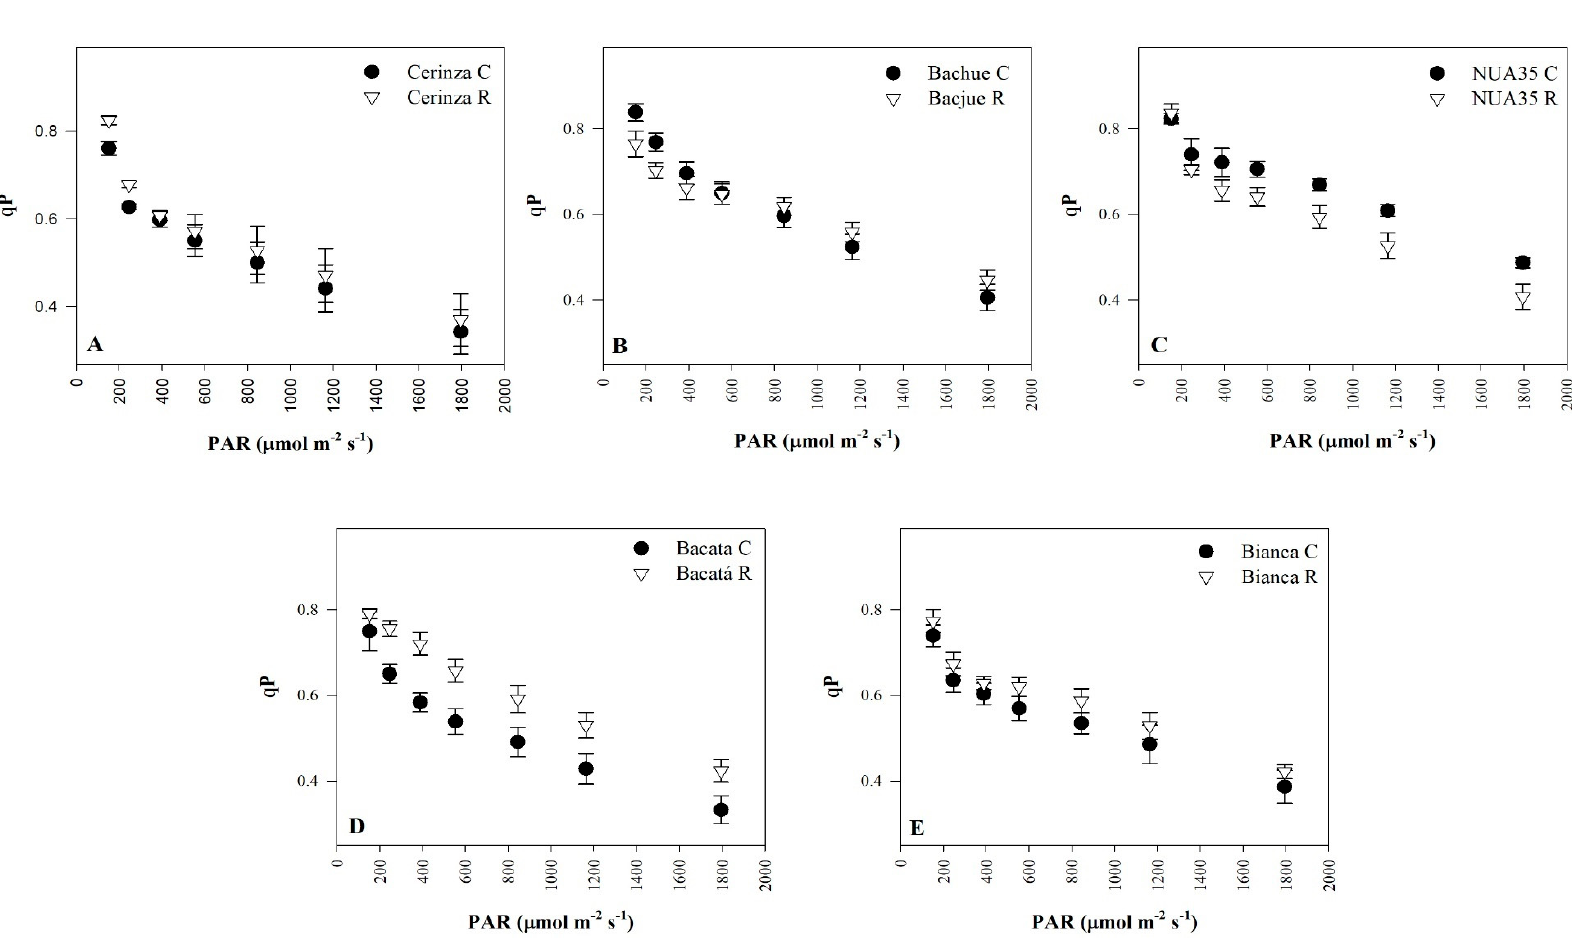
Figure 5. Photochemical quenching (qP) obtained from rapid light-response curves of ‘Cerinza’ ( A ), ‘Bachue’ ( B ), ‘NUA35’ ( C ), ‘Bacata’ ( D ) and ‘Bianca’ ( E ) under two water treatments (control ( (cid:8) ) and water-stressed ( (cid:53) ) plants) at the end of reproductive stage (65 DAE). Data represent the mean of four data points ± standard error.